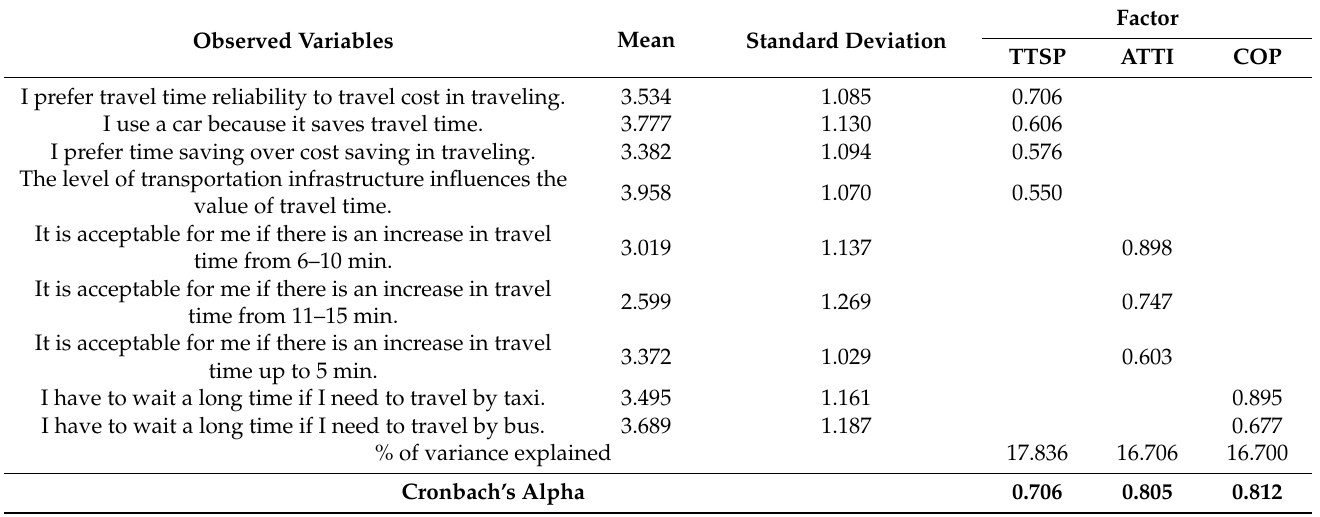
Table 3. Rotated factor loadings of preferences in